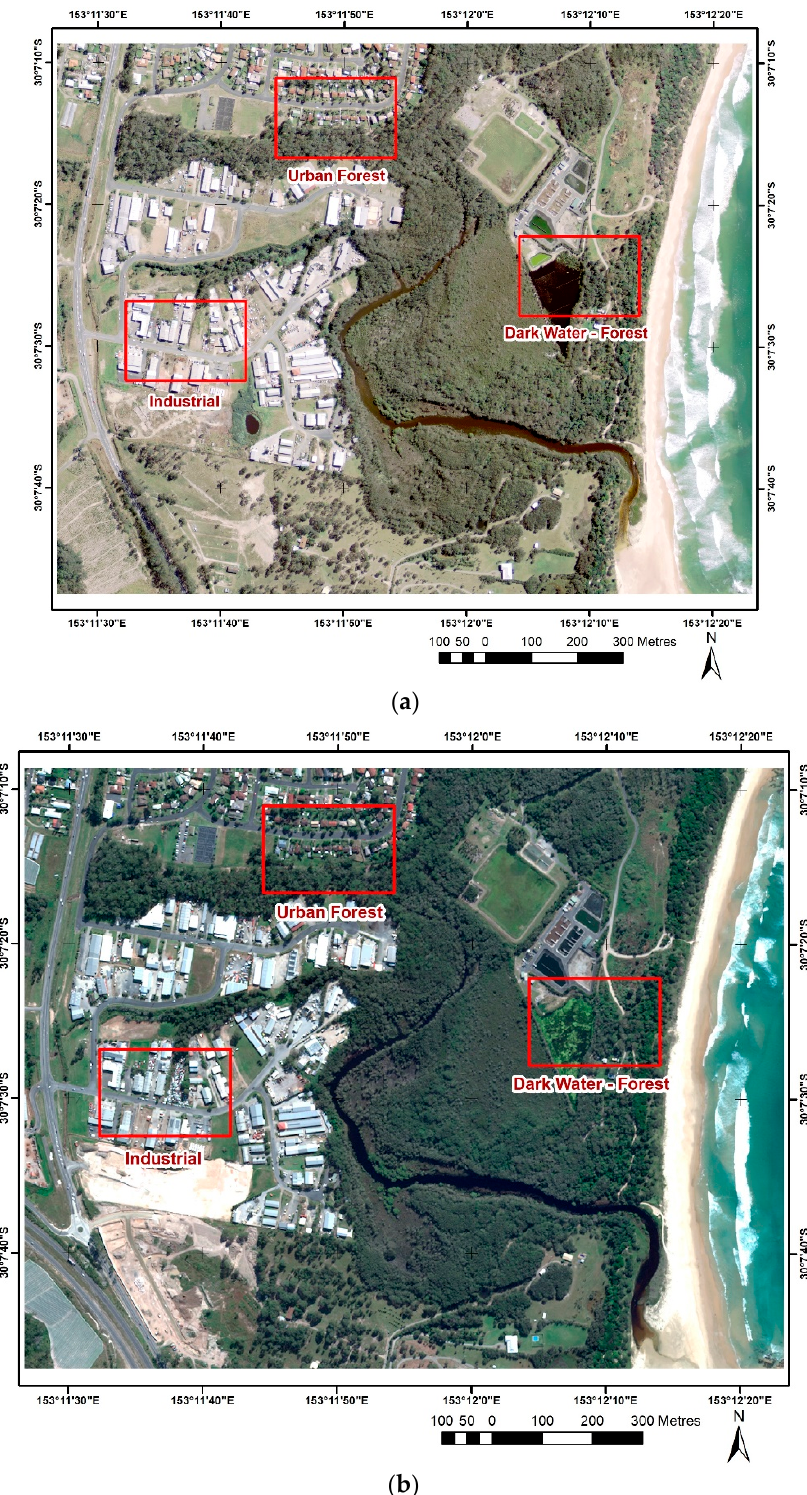
Figure 5. Study area showing images and target subset areas. ( a ) ADS40 image, ( b ) Worldview-3 image. Urban Forest, Dark Water-Forest and Industrial subsets are used for shadow target detection and are shown in red.